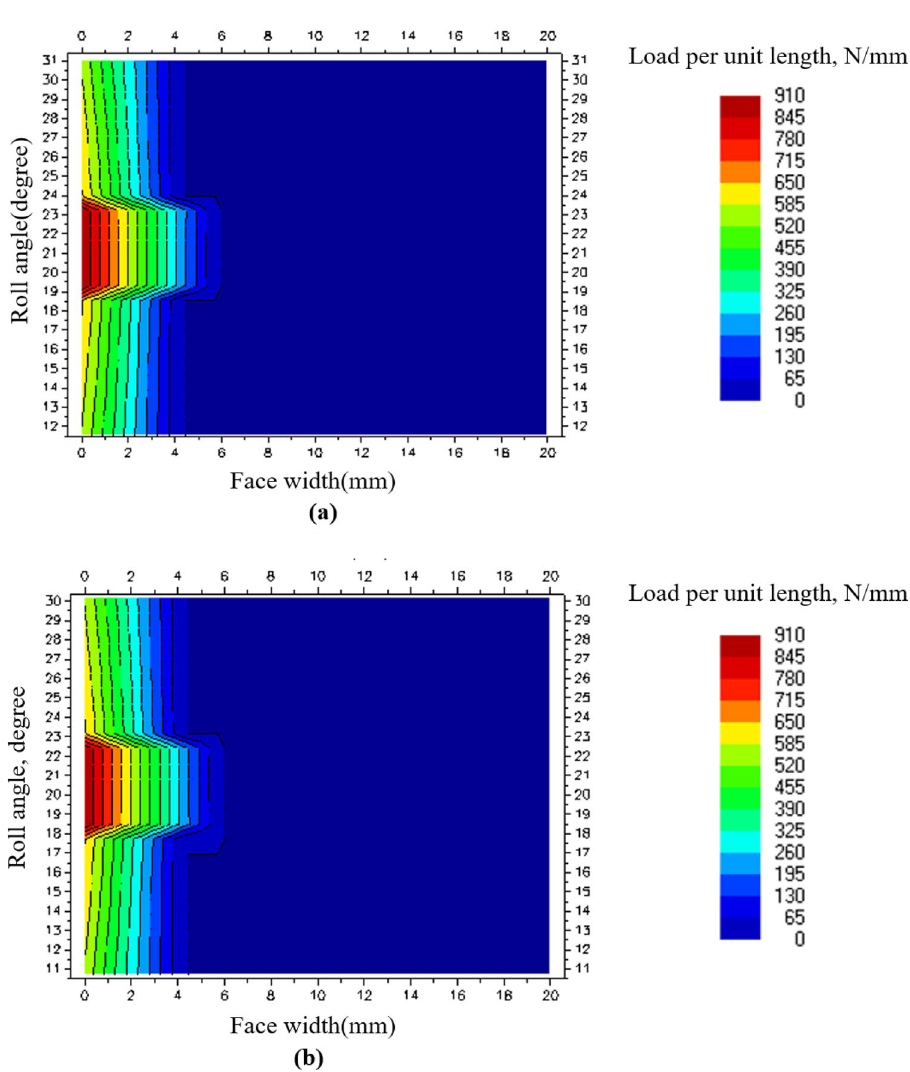
Figure 4. Face load distribution of SGS 1 on load level 8: ( a ) Pinion contact pattern and ( b ) gear contact